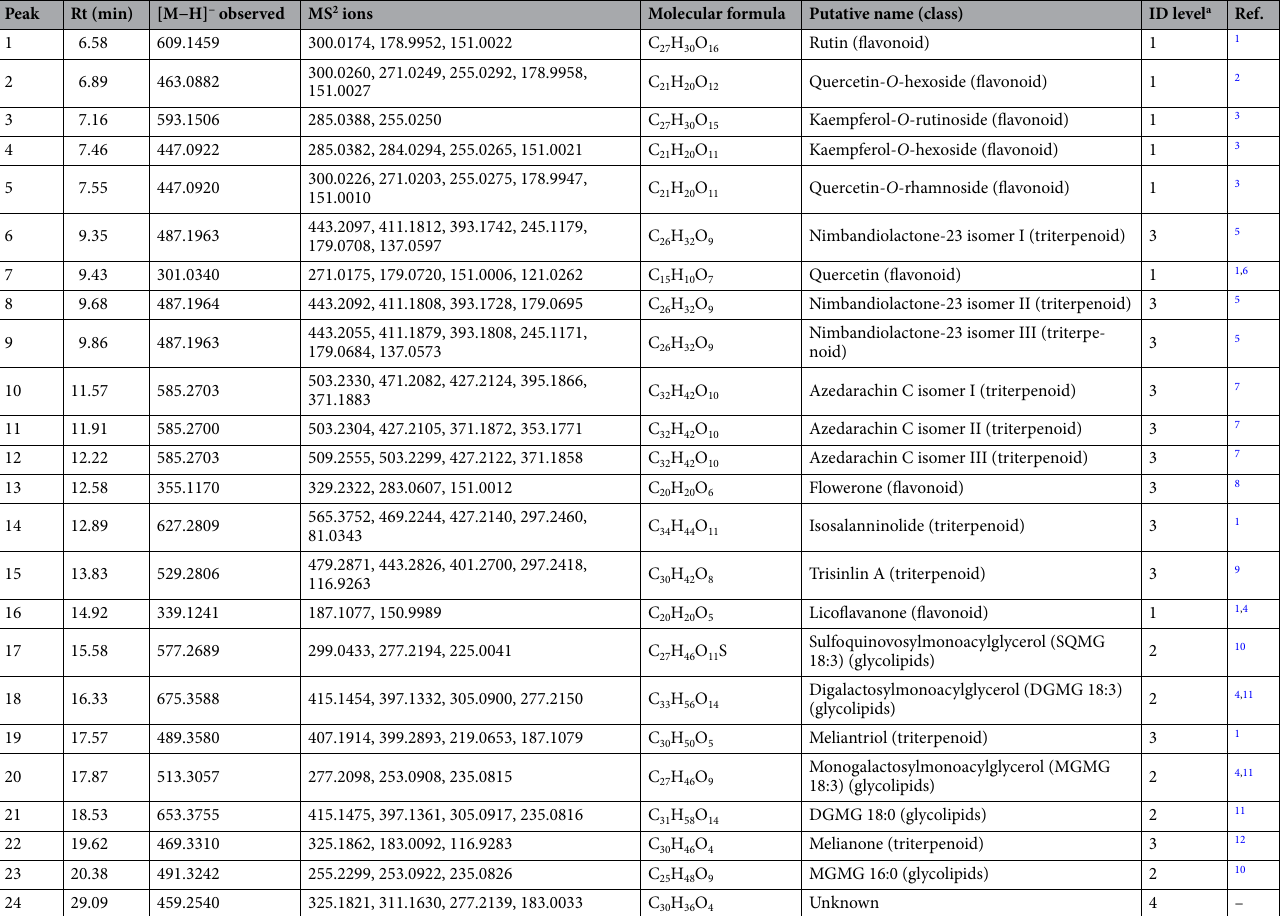
Table 3. Compounds putatively identified in ethyl acetate fraction from Azadirachta indica leaves by UPLC- ESI-QTOF-MSE in negative ionization mode. a Identification level: 1. Exact mass, MS/MS (Mass Spectrometry) fragments and occurrence; 2. Exact mass and MS/MS fragments; 3. Exact mass and occurrence; 4. Not